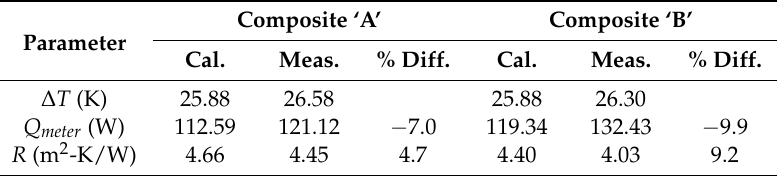
Table 6. Comparison measurements and calculations of large-scale